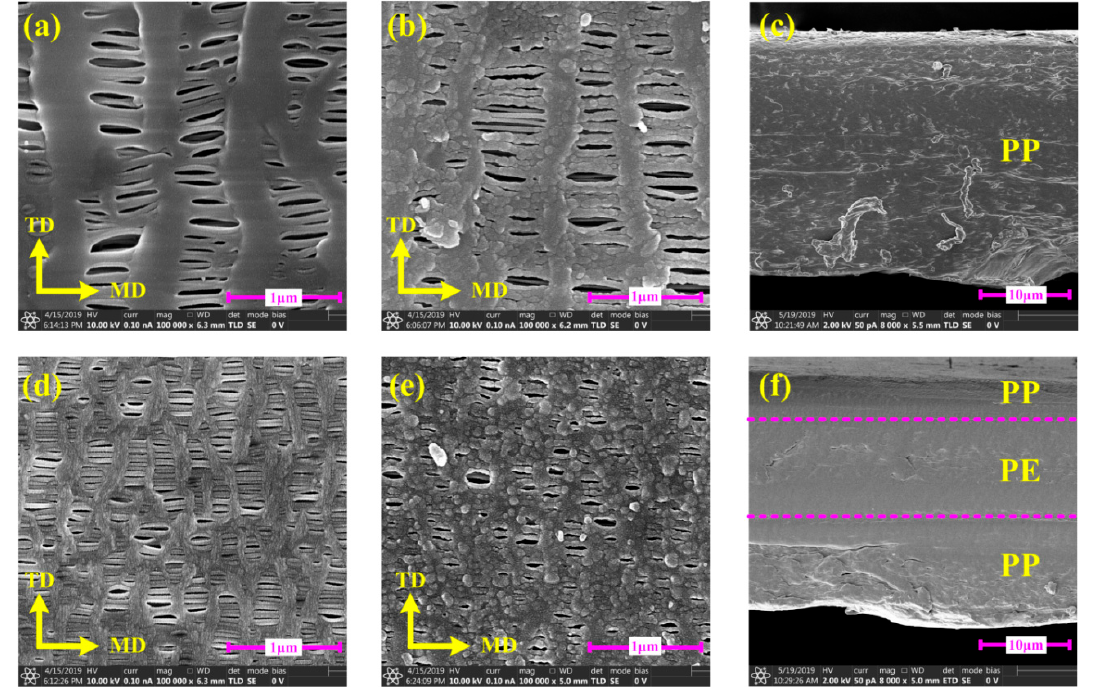
Figure 3. Field emission scanning electron microscope (FE-SEM) images of unmodified and PDA-modified separators on the surface and cross-section: ( a,b ) unmodified and PDA-modified polypropylene (PP) separators on the surface; ( c ) unmodified PP separator on the cross-section; ( d,e ) unmodified and PDA-modified polypropylene / polyethylene / polypropylene (PP / PE / PP) separators on the cross-section; ( f ) unmodified PP / PE / PP separator on the cross-section.